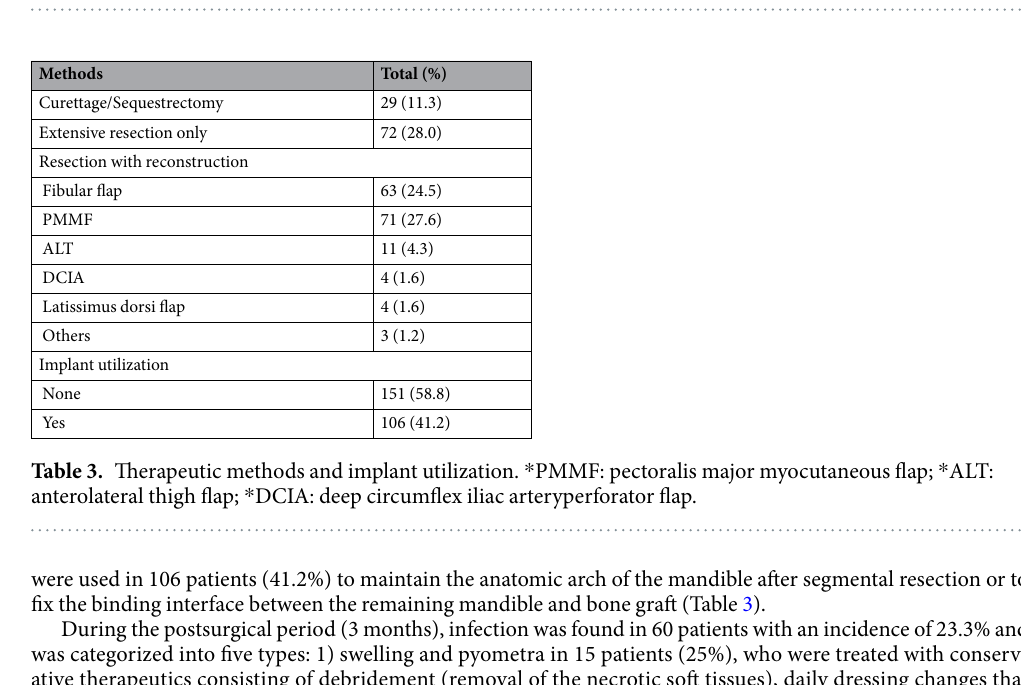
Figure 4. Clinical manifestations of ORNM and their distribution among patients.